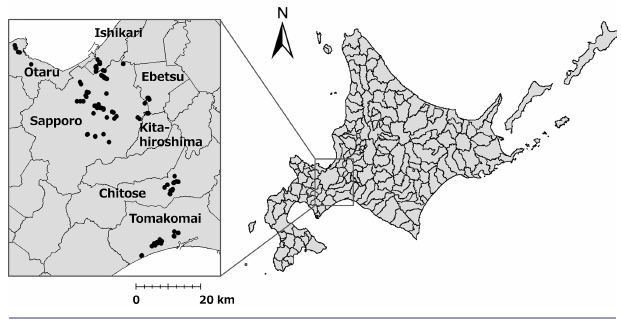
Fig. 1 . Study area and experimental plots. We conducted the experiments in Sapporo and six adjacent cities. Dots mean experimental